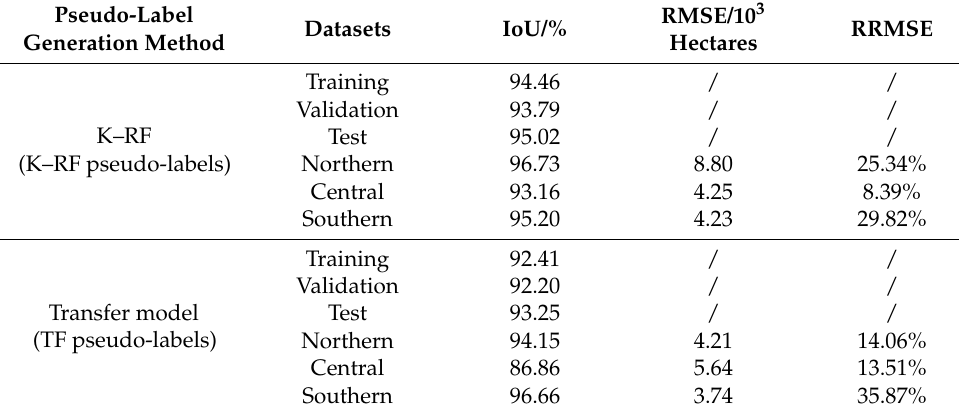
Table 3. Consistency of pseudo-labels and extraction results.